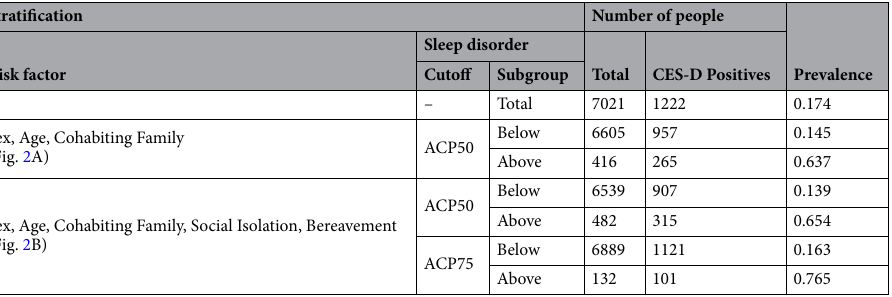
Table 2. Prevalence of Center for Epidemiologic Studies Depression positivity in each category classified by ACP50 or ACP75.